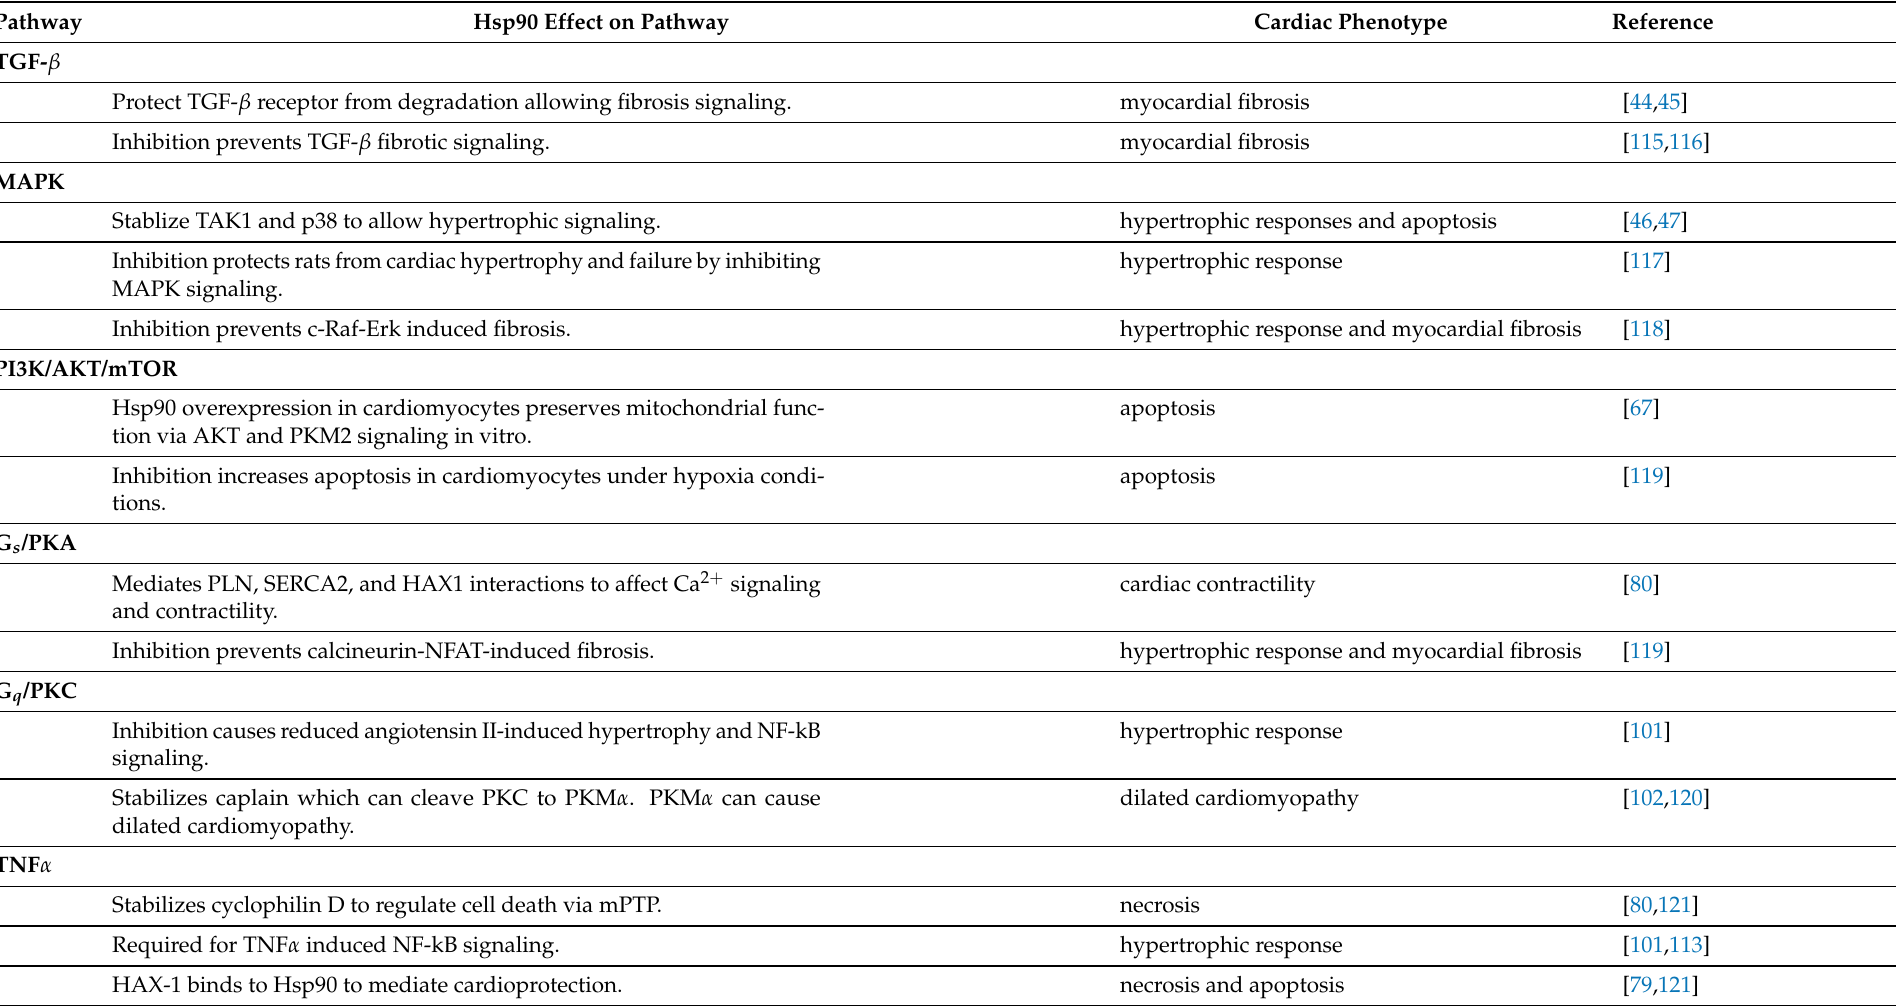
Table 1. Summary of Hsp90 involvement and effects of inhibition of Hsp90 on the aforementioned pathways as well as the phenotypic result of modulating Hsp90 in the heart. Evidence for Hsp90 involvement in pathophysiology can be found, however, it is a relatively new approach to investigating cardiomyopathy so studies are limited.